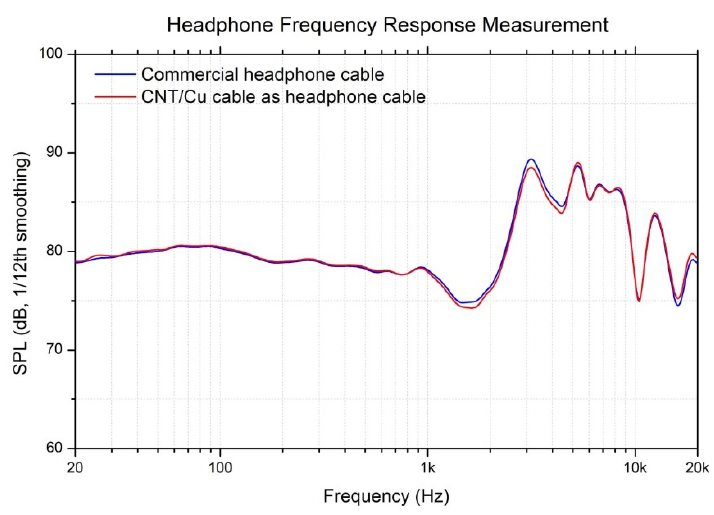
Figure 6. The frequency response of the HiFiMAN Arya headphones (right channel, averaged over three measurements) using a commercial headphone cable compared to the CNT/Cu cable as the headphone cable. Both are within error margins once the volume is matched.